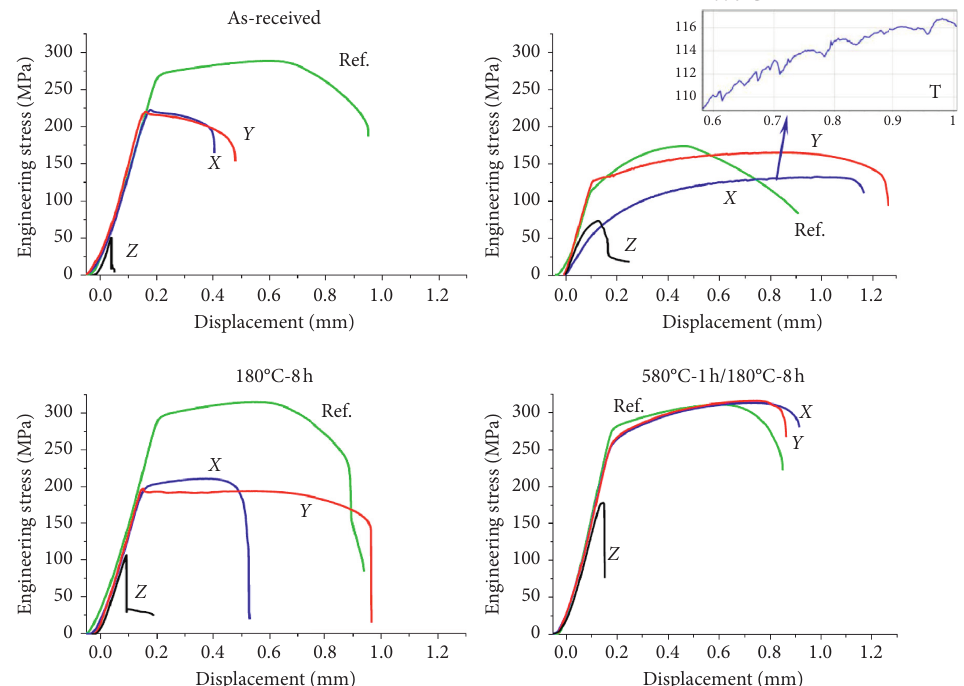
Figure 16: Engineering stress versus displacement curves illustrating the effect of annealing on the mechanical behavior of the UAM Al6061 [13]. Table 4: Fatigue test data for Al-Al and Al specimens [35]. Specimen